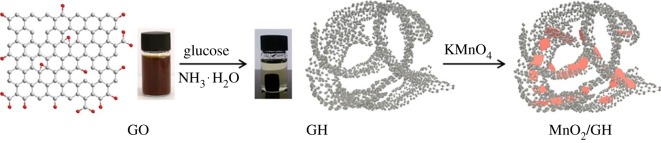
Schematics of the synthesis process of GH and MnO2/GH. Adapted from ACS Publications.